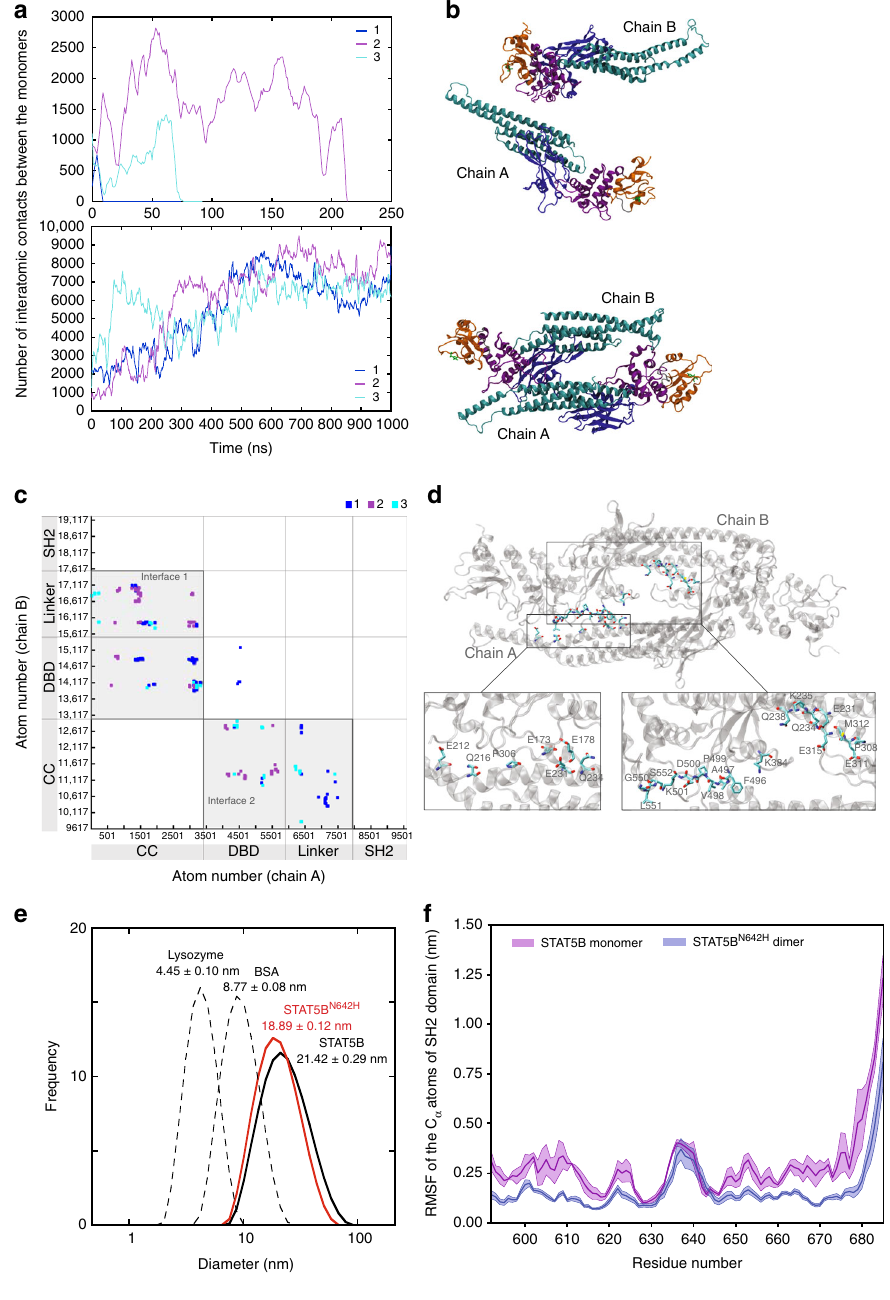
Fig. 7 STAT5B and STAT5B N642H dimer interfaces and fl exibility of the SH2 domain. a The number of contacts formed between the monomers in the unphosphorylated anti-parallel dimeric structures of STAT5B (top) and STAT5B N642H (bottom) as a function of simulation time. The three curves correspond to three independent simulations. Contacts are de fi ned if any two atoms are within 6 Å; moving average over every 5 ns is plotted. b The structures of the STAT5B (system 3) at 75 ns depicting dimer dissociation (top) and STAT5B N642H (system 1) at the end of 1 µ s simulation (bottom). The color scheme in b corresponds to the individual domains: CCD, cyan; DBD, blue; linker domain, purple; SH2 domain, orange. Residue 642 is highlighted in green. c Inter-chain contacts formed over the 1 µ s simulation, shown by the atom pairs within a minimum inter-atomic distance within a 6 Å cutoff. The boundaries of the individual domains are shown for clarity, and the two dimer interfaces are highlighted in gray boxes. d Sustained inter-chain contacts formed over the 1 µ s simulation. The bottom panel demonstrates the hot-spot residues in licorice representation (chain A, left; chain B, right). See the simulation methods for the de fi nition of the inter-chain contacts. Dynamic light scattering experiments in e show that STAT5B N642H (50 µ M) adopts a more closely packed dimer compared to STAT5B (50 µ M). The values for diameter are reported ± SD as the average of three independent runs. f Root mean square fl uctuation (RMSF) of the α -carbon atoms of the SH2 domain in STAT5B monomer and STAT5B N642H dimer. The shading indicates statistical uncertainty. Source data are provided as a Source Data fi